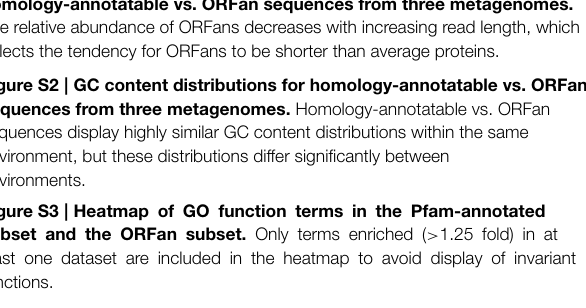
Figure S2 | GC content distributions for homology-annotatable vs. ORFan sequences from three metagenomes. Homology-annotatable vs. ORFan